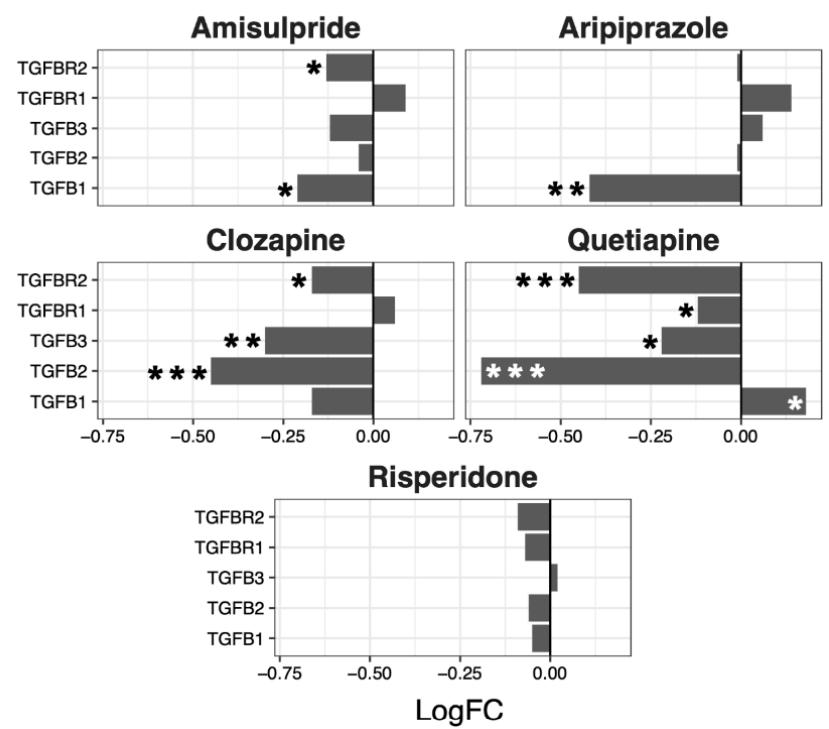
Figure 5. TGF β signaling pathway genes regulated by psychotropic drug treatment in NT2-N cells expressed as log fold change relative to vehicle-treated cells. * p < 0.05, ** p < 0.005, and *** p < 0.001.